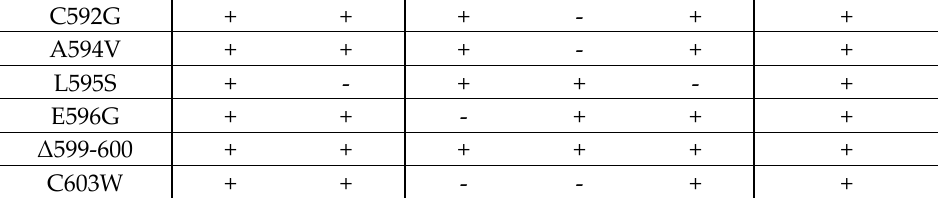
Figure 3. Interaction analysis of TB40-IE2-YFP ORF-UL97 resistance mutants with human cyclins. HFFs in T75 flasks were infected with HCMV TB40-IE2-YFP WT or newly generated ORF-UL97 point mutants. Cells were harvested between 4 and 7 d.p.i., when approximately 80% of the cells showed a cytopathic effect. Cells were lysed, and human cyclins T1 ( A ), H ( B ), and B1 ( C ) were immunoprecipitated using specific antibodies. A chicken Fc fragment served as specificity control, and lysate taken prior to immunoprecipitation was used as input control. All samples were subjected to Wb analysis, and proteins were detected using specific monoclonal and polyclonal antibodies. ( D ) A summary is given of biological replicates (Rep1, Rep2, Rep3) monitoring the interaction of pUL97 mutants with human cyclins T1, H, and